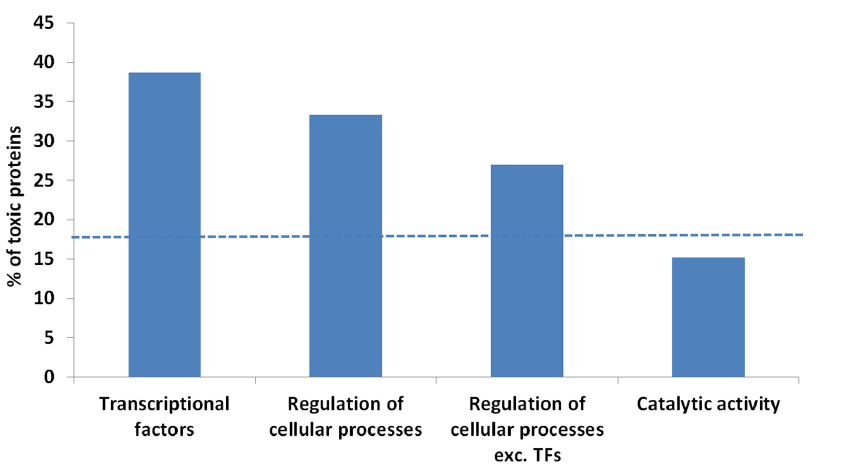
Figure 4. Functional classes associated with toxicity. Percentage of toxic proteins is much higher in transcription factors (Fisher p =1e-13) and in ‘‘regulation of cellular processes’’ (Fisher p =1e-13). ‘‘regulation of cellular processes’’ was enriched in toxic proteins even after excluding transcription factors (Fisher p =3e-5). Catalytic proteins were significantly depleted in toxic proteins (Fisher p =3e-4). Dotted line indicates overall average in cytoplasmic proteins.